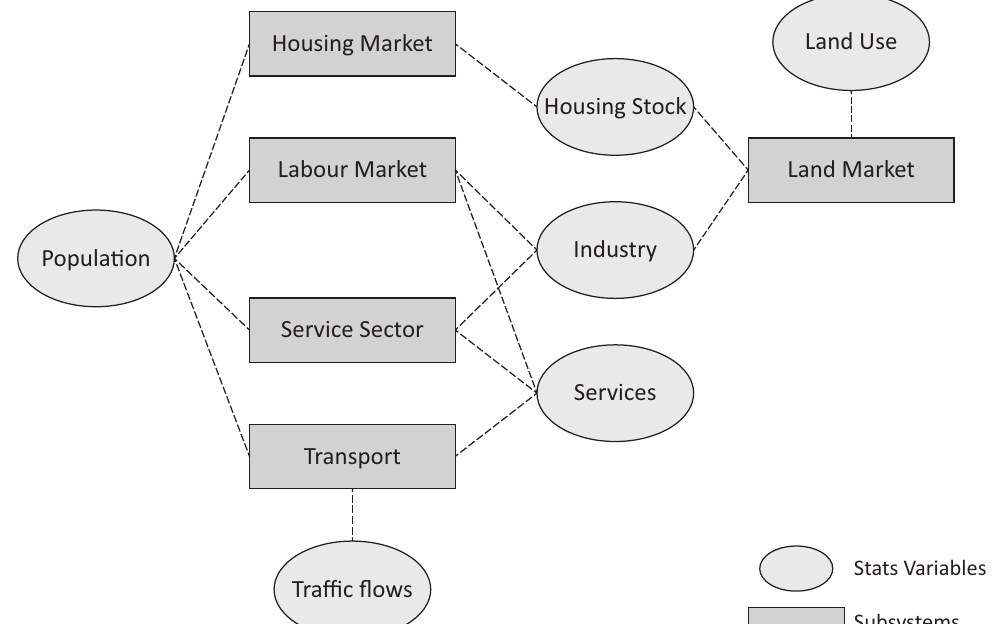
Figure 1. Urban system diagram of subsystems and corresponding variables. Source: Bertuglia et al. (1987, 1994). Urban Planning, 2017, Volume 2, Issue 2, Pages